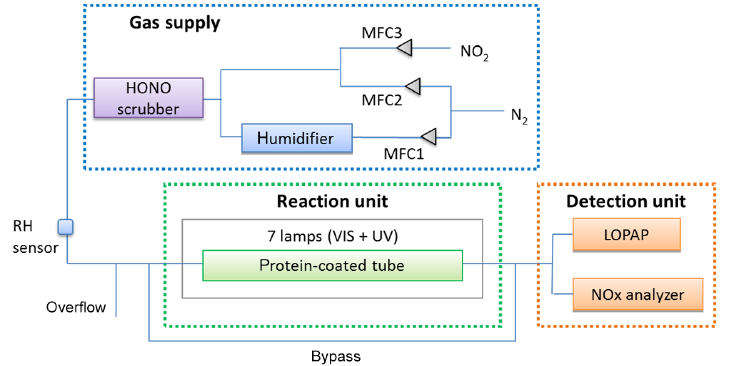
Figure 2. Flow system and setup: thin blue lines show the flow of the gas mixture, which direction is indicated by the grey triangles of the mass flow controllers (MFC). Nitrogen passes a heated water bath to humidify the gas and a HONO scrubber to eliminate any HONO impurities of the NO 2 supply. The overflow maintains a constant pressure through the reaction tube and the detection unit. The dotted boxes (blue, green, orange) indicate the three different parts: the gas supply, reaction unit and detection